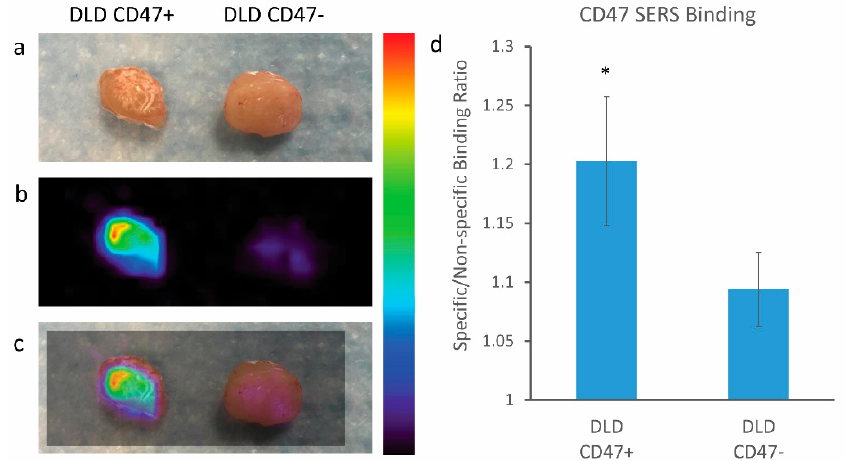
Figure 6. Raman imaging of positive and negative CD47 expressing tissues (DLD+ and DLD − , respectively) harvested from mouse xenograft. ( a ) Digital photo of excised tissue after NPs administration; ( b ) Raman imaging of tissue samples; ( c ) overlay of Raman imaging with tissue sample, notice the increased NP binding in the tissue expressing CD47 as opposed to the negatively CD47 expressing tissue; ( d ) quantitative ratiometric analysis of specific CD47 SERS NP binding to non-specific Isotype IgG SERS NP binding on tissue samples Notice the significant differences represented by * ( p < 0.05) between the positive control (DLD CD47+) and the negative control (DLD CD47 − ) tissues; error bars represent standard error of mean (SEM). Color bar to the right of Raman images represents Raman intensity, where red represents the highest Raman signal and black represents no associated Raman signal.